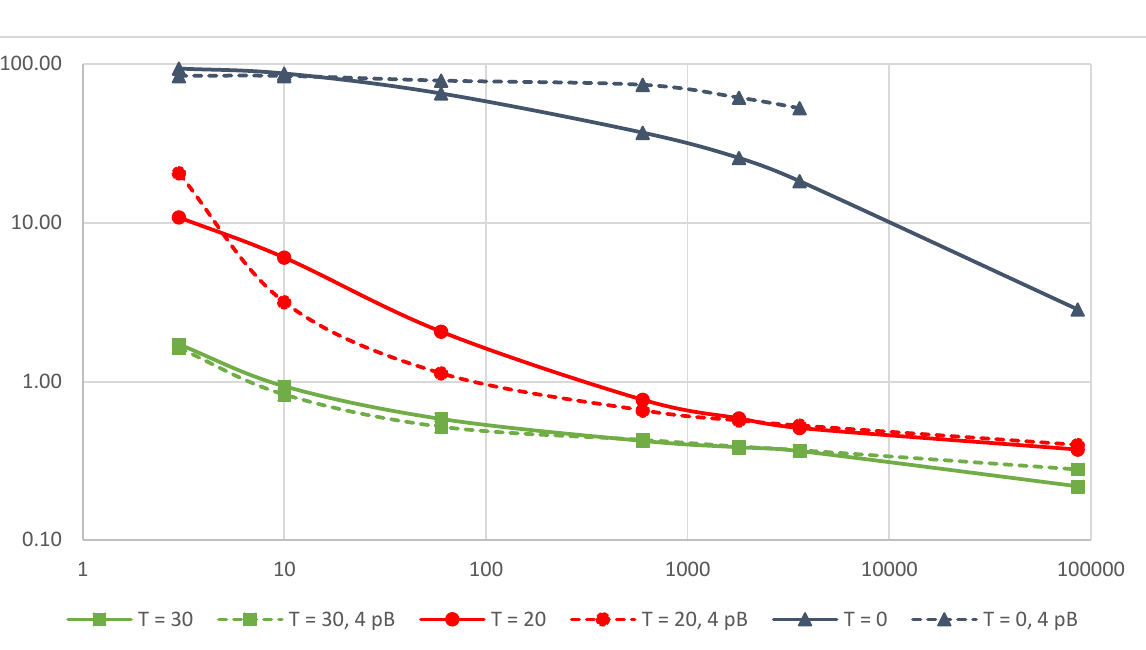
Fig. 4 Shear relaxation modulus for conventional PVB for durations between 3s and 24 hours at different temperatures for the model of Table 1 (DMA, solid lines), and as derived from four point bending experiments (dotted lines,